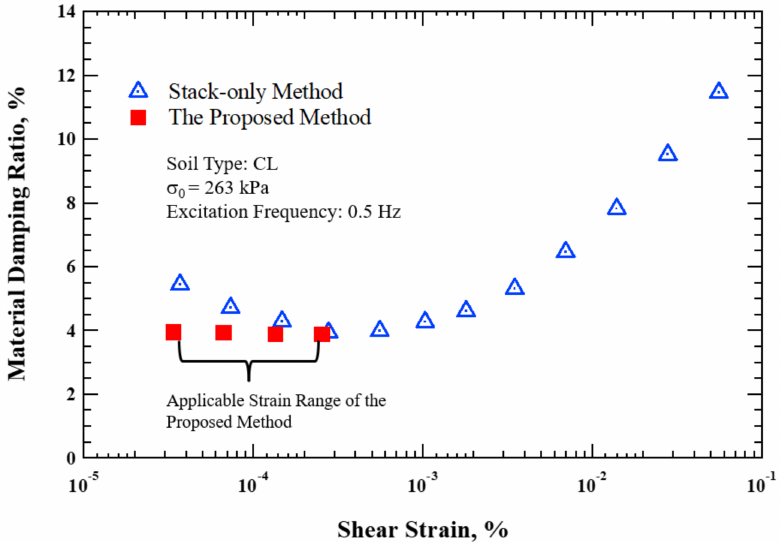
Figure 10. Applicable strain range of the proposed